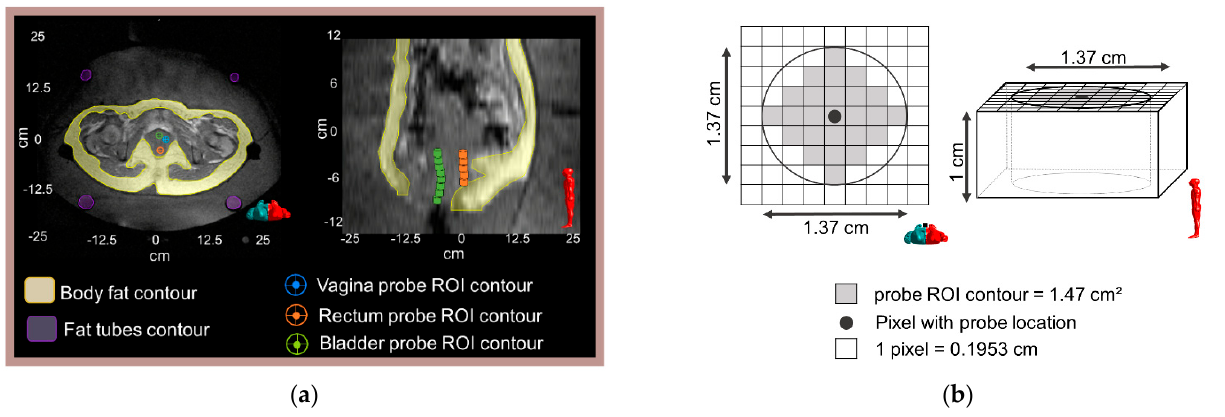
Figure 2. ( a ) An axial and a sagittal T1-weighted MR image of the pelvic are shown along with an illustration of the location of the Bowman probes points and the corresponding delineated ROIs: vagina, rectum, and bladder. The left and right images correspond to the middle axial slice (z = − 2 cm) and middle sagittal slice (x = 0 cm), respectively. Body fat and fat-like tube ROIs are indicated in the axial MR image. ( b ) Schematic representation of the probe ROI contour in the axial and sagittal view.